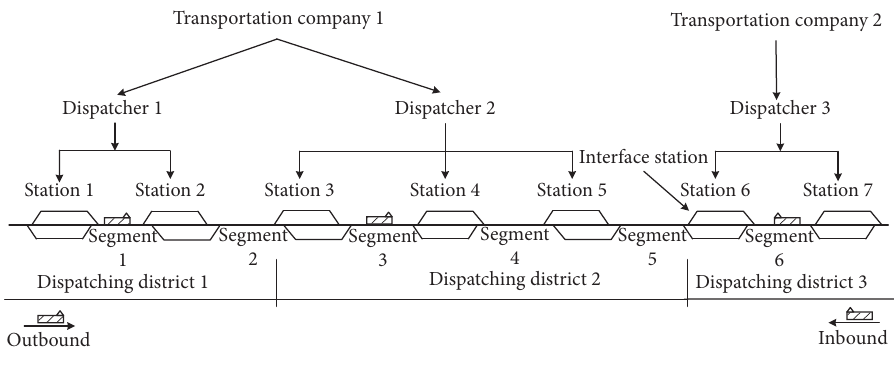
Figure 1: A simplified organization and management of train